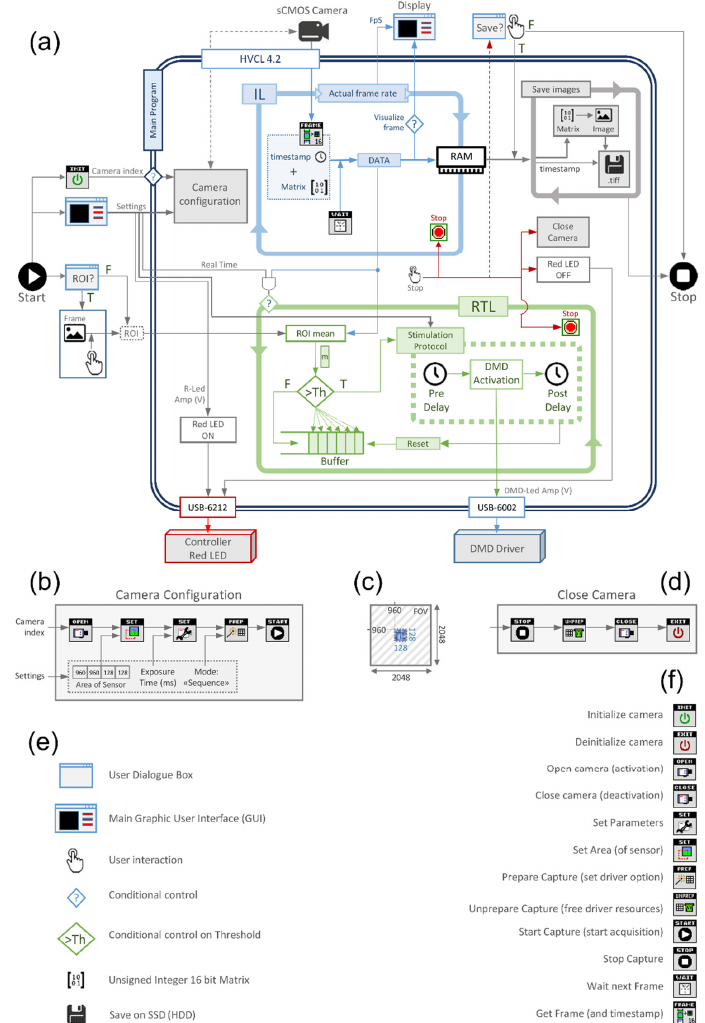
Figure 2. Conceptual Scheme of the LabVIEW Program Architecture. ( a ) Scheme of the LabVIEW program that manages the whole optical-mapping setup. The main program is principally composed by two loops: the IL (imaging loop) in blue and the RTL (real-time loop) in green. LED, light-emitting diode; sCMOS, scientific complementary metal-oxide semiconductor; DMD, digital micro-mirror device; HVCL, Hamamatsu video capture library; ROI, region of interest; FpS, frame per second; RAM, random access memory; R-Led, red LED; Amp (V), amplitude (Volts); USB, universal serial bus; F, false; T, true; Th, threshold; TIFF, tagged image file format. ( b ) Camera configuration. This block contains the HVCL functions to prepare the camera. ( c ) Representation of the portion of the camera sensor used. FOV, field of view. ( d ) Close camera. This block contains the operations to correctly stop and close the connection with the camera. ( e ) Legend of the symbol used in panel ( a ). SSD, solid state drive; HDD, hard disk drive. ( f ) List of the Hamamatsu Video Capture Library (HVCL) functions